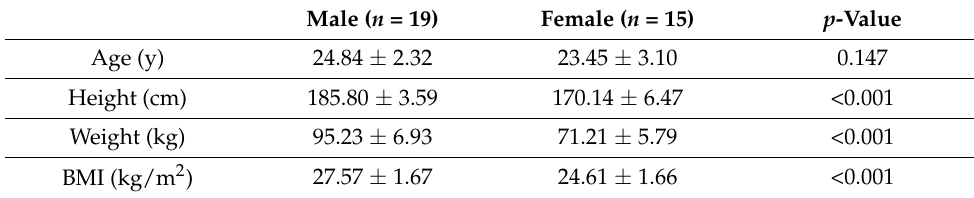
Table 1. Demographic characteristics of study participants based on sex ( n =